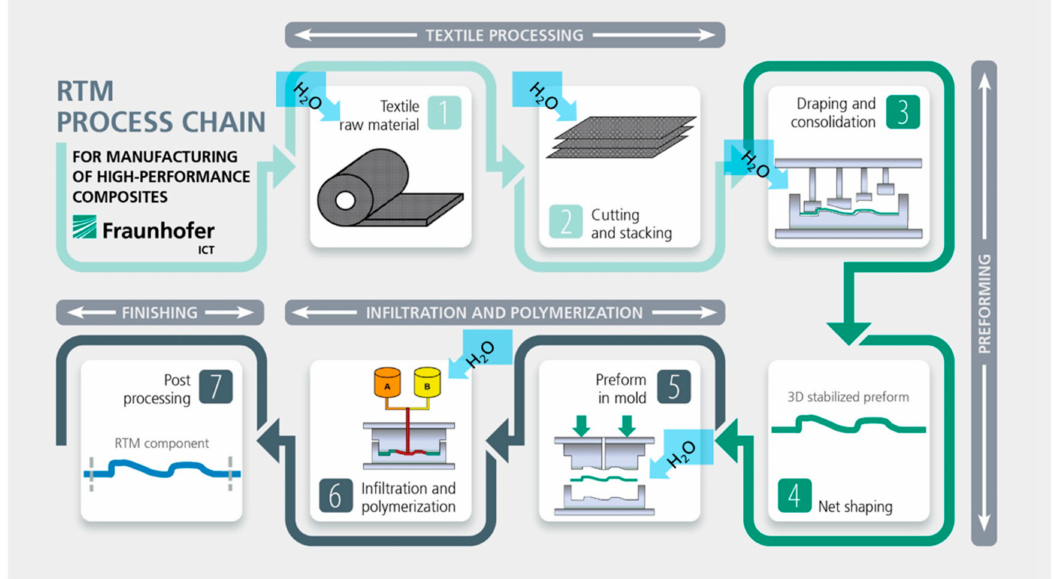
Figure 1. Schematic overview of a typical thermoplastic resin transfer molding (T-RTM) process chain with the influence of